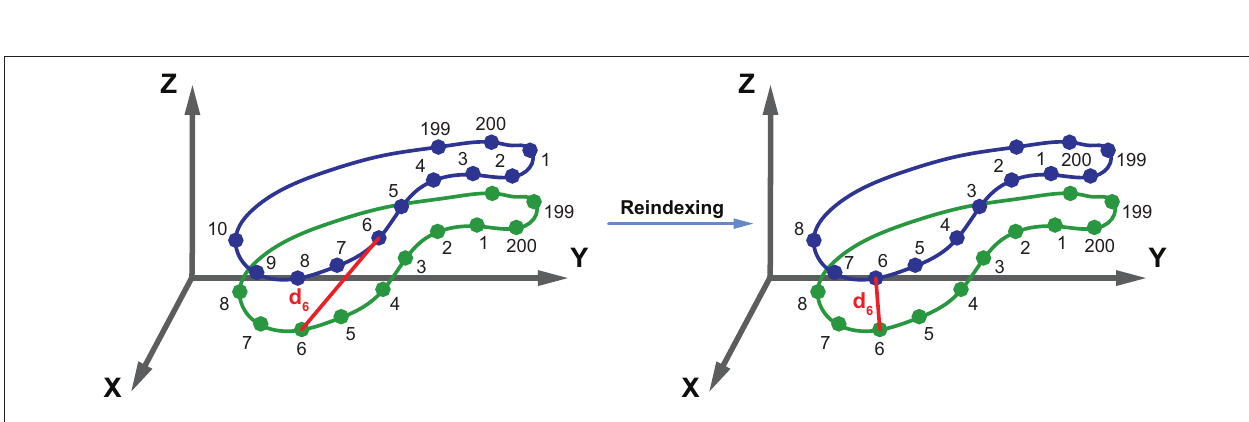
where R is the reference slice (i.e., the middle slice of the end- diastolic point cloud), S is the slice that is being reindexed (i.e., the middle slice of the end-systolic point cloud), and I is the function for reindexing that returns the corresponding index of the contour point in S for the k th point of R ( Figure 5 ). Then, the same method was applied to reassign the indices of the remaining slices within each point cloud using the previously reindexed middle slice as a